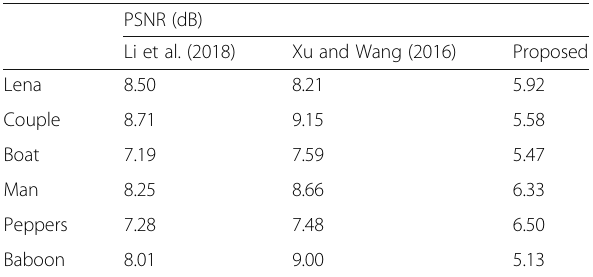
Table 1 PSNR comparisons among Xu and Wang ’ s work [18], Li et al. ’ s work [20], and ours